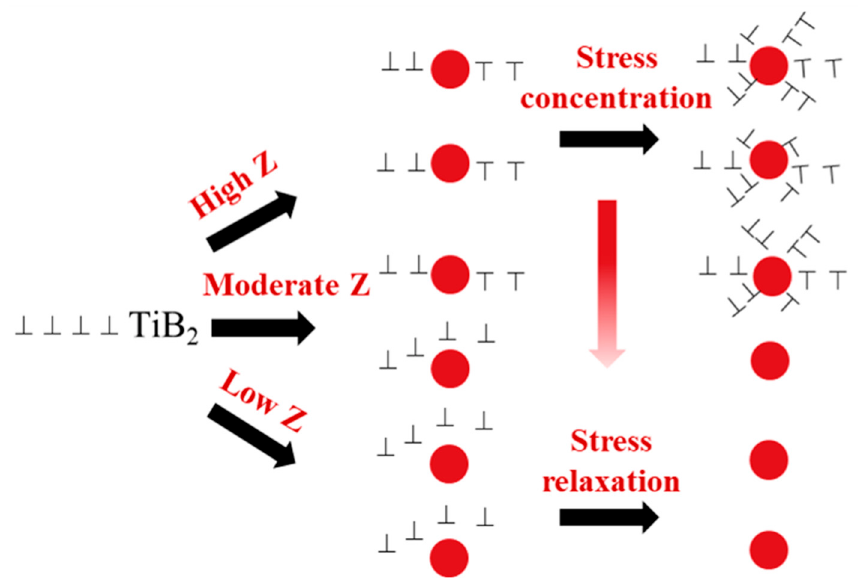
Figure 11. Schematic diagram of interactions of TiB 2 particles and dislocations during hot deformation.